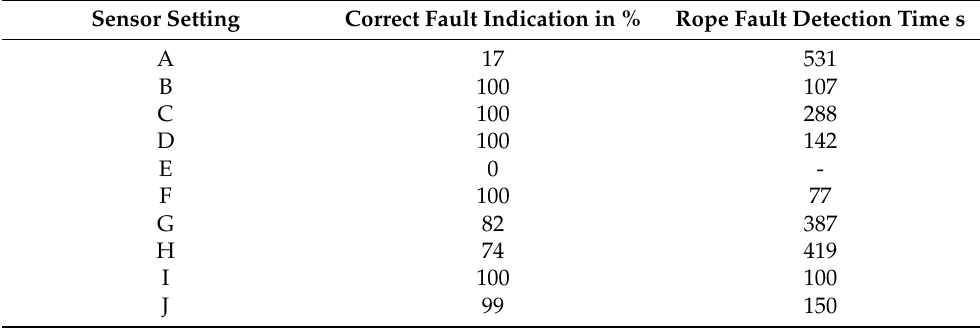
Table 1. Fault detection parameters for 2, 3, 4, 5 and 7 acceleration measurements per